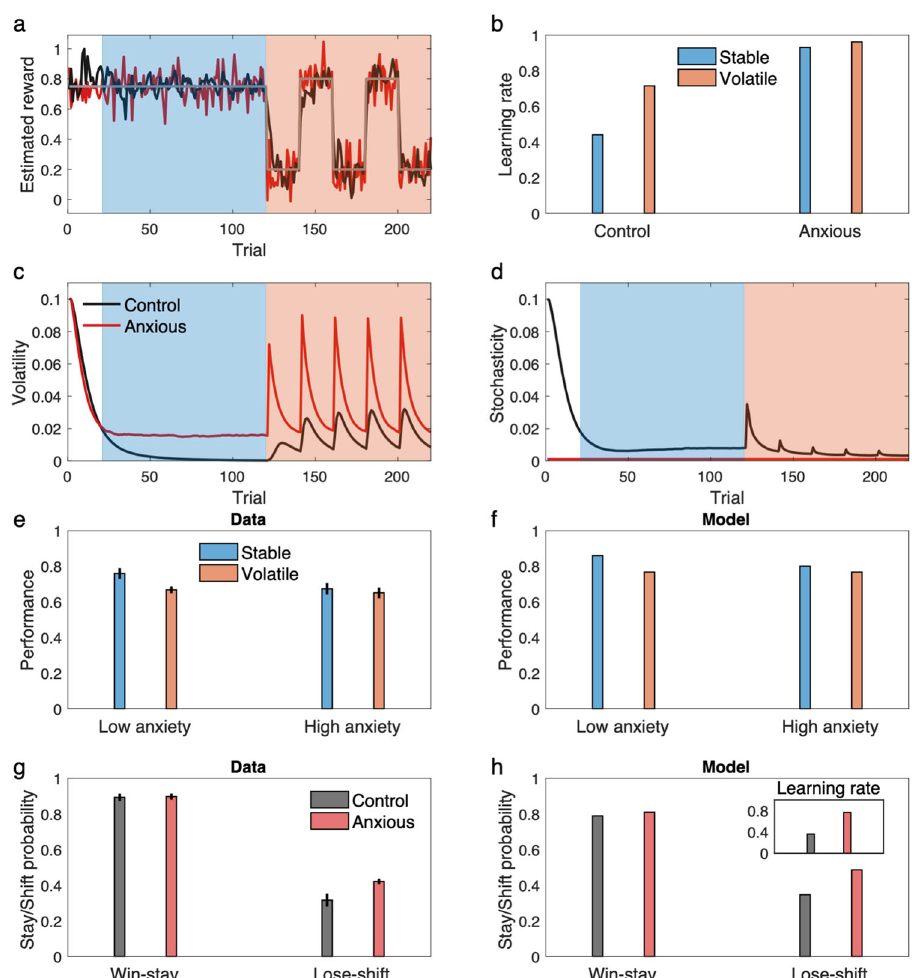
Fig. 5 The stochasticity lesion model shows a pattern of learning de fi cits associated with anxiety. Behavior of the lesioned model as the model of anxiety, in which stochasticity is assumed to be small and constant, is shown along the control model. a – d Behavior of the models in the switching task of Fig. 2 is shown. An example of estimated reward by the models shows that the model with anxiety (i.e., the stochasticity lesion model) is more sensitive to noisy outcomes ( a ), which dramatically reduces sensitivity of the learning rate to volatility manipulation in this task ( b ). This, however, is primarily related to inability to make inference about stochasticity, which leads to misestimation of volatility ( c – d ). e – f The model explains the data reported by Piray et al. 20 , in which the high (social) anxiety group did not bene fi t from stability as much as the low anxiety group ( e ). The model shows the same behavior ( f ). g – h The model explains the data by Huang et al. 32 , in which the anxious group showed higher lose-shift behavior compared to the control group ( g ). The model shows the same behavior ( g ), which is due to higher learning rate in the anxious group (inset). Errorbars in ( b ), ( f ), and ( h ) re fl ect standard error of the mean over 1000 simulations and are too small to be visible. Data in ( e ) are adapted from Piray et al. 20 in which median and standard error of the median are plotted (obtained over n = 44 samples). Data in ( g ) are adapted from Huang et al. 32 , in which mean and standard error of the mean are plotted (obtained over n = 122 independent samples.) Source data are provided as Source Data fi